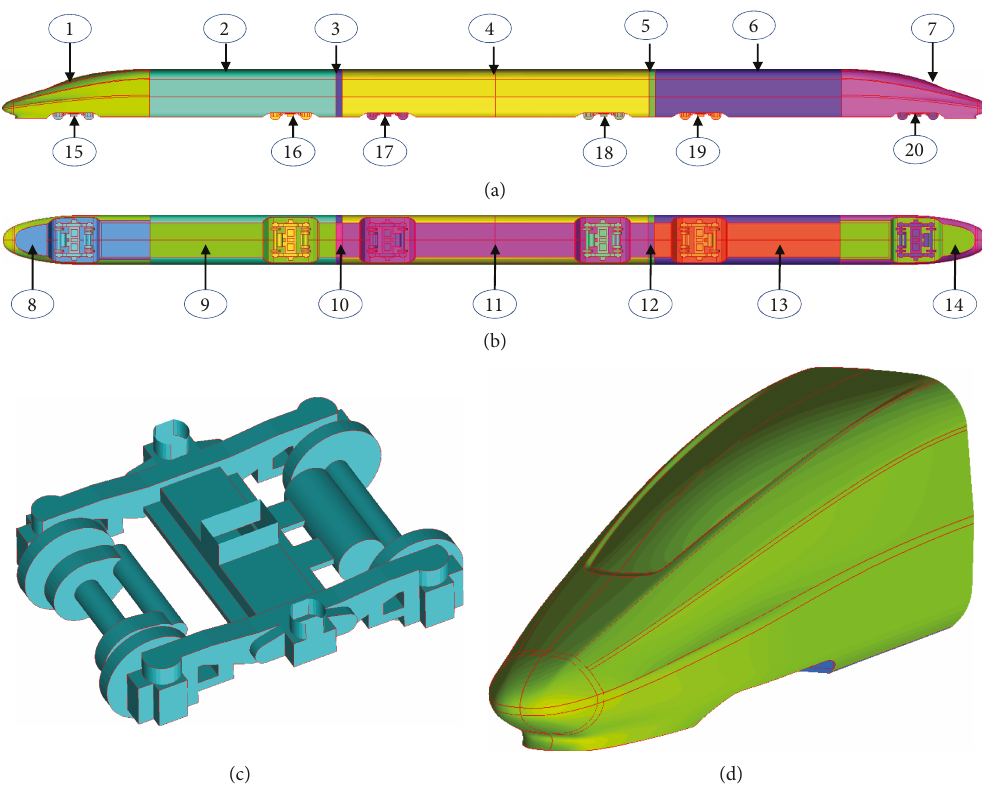
Figure 1: Geometric structure of the high-speed train: (a) front view, (b) bottom view, (c) bogie, and (d) the streamlined part. The list of components in the fi gure is as follows. 1: the upper part of the head car ’ s streamlined part; 2: the upper part of the head car ’ s carriage; 3: the upper part of the intercoach windshield 1; 4: the upper part of the mid-car; 5: the upper part of the intercoach windshield 2; 6: the upper part of the tail car ’ s carriage; 7: the upper part of the tail car ’ s streamlined part; 8: the bottom of the head car ’ s streamlined part; 9: the bottom of the head car ’ s carriage; 10: the bottom of the intercoach windshield 1; 11: the bottom of the mid-car; 12: the bottom of the intercoach windshield 2; 13: the bottom of the tail car ’ s carriage; 14: the upper part of the head car ’ s streamlined part; 15: bogie 1; 16: bogie 2; 17: bogie 3; 18: bogie 4; 19: bogie 5; and 20: bogie 6. fi rst bogie to the sixth bogie, sequentially; the three cars from the upstream to the downstream were named the head car, the mid-car, and the tail car, sequentially. The streamlined parts of the head car and the tail car are named indepen- dently. The bottom of each carriage is independently named.